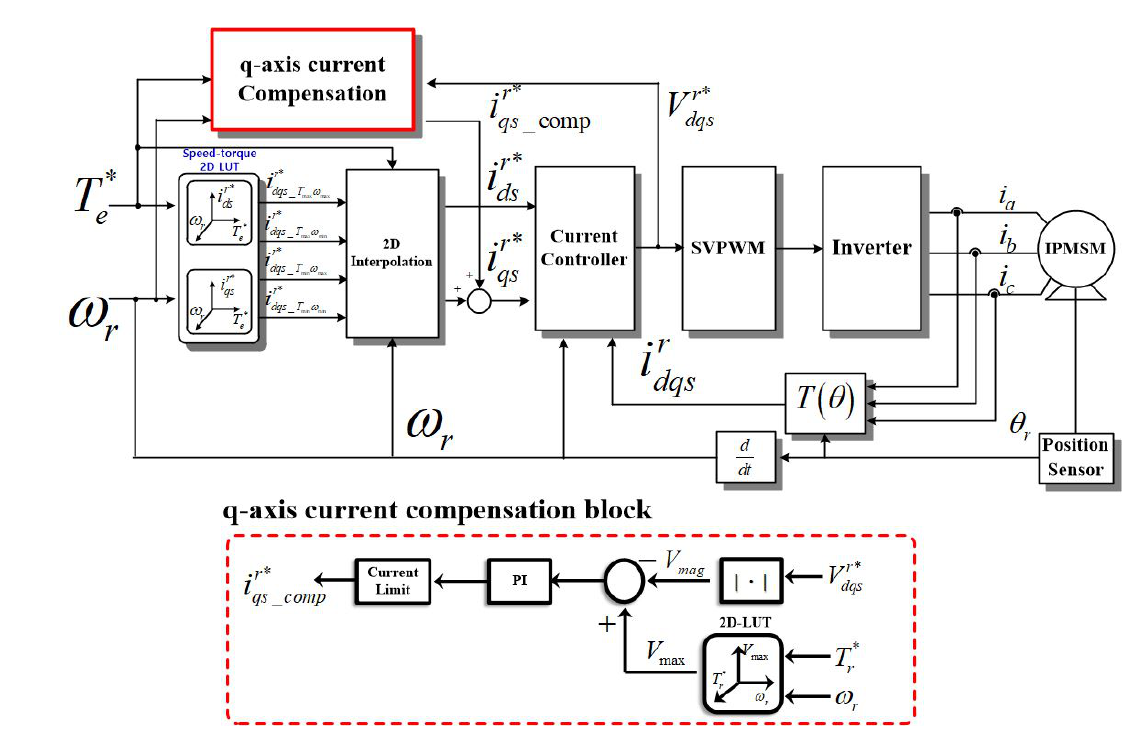
Figure 3. Conventional interpolation error compensation overall block